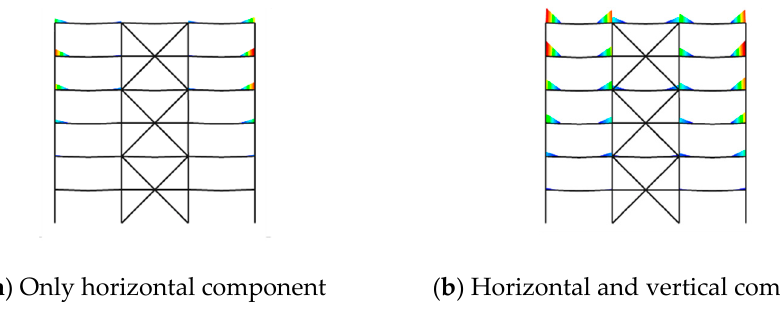
Figure 9. Plastic hinges for earthquake JAMI at the end of the seismic register. The red/blue color in the color contours indicates higher/lower degree of plastic rotation.